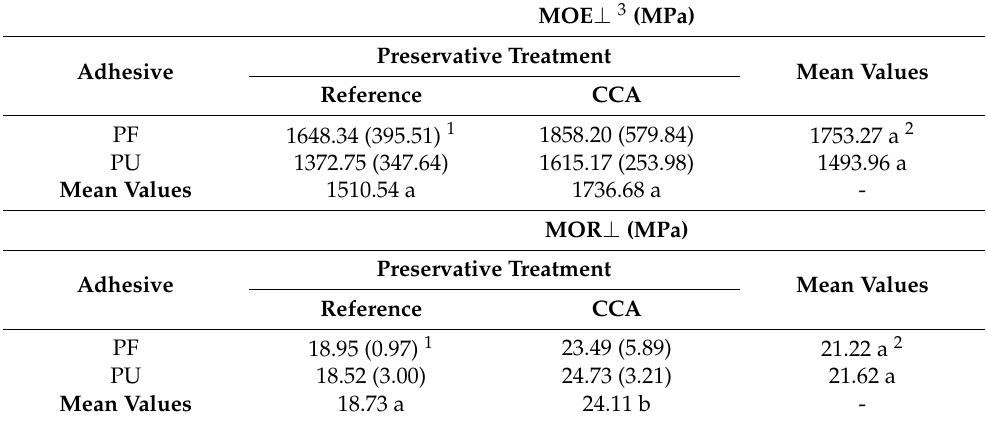
Table 9. Perpendicular static